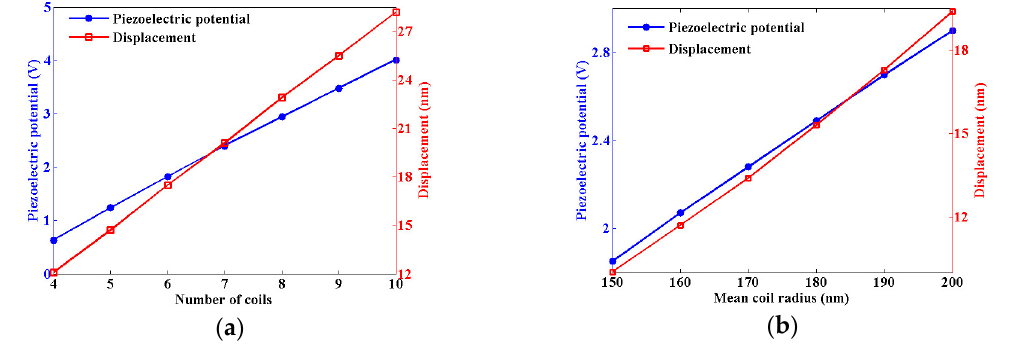
Figure 3. The change of the maximum piezoelectric potential and displacement with the number of coils in ( a ) and the mean coils radius in ( b ) of ZnO nanohelices with a constant length of 1900 nm.